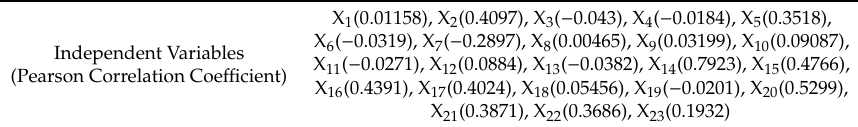
Table 2. Pearson correlation coe ffi cient of independent variables to the real estate